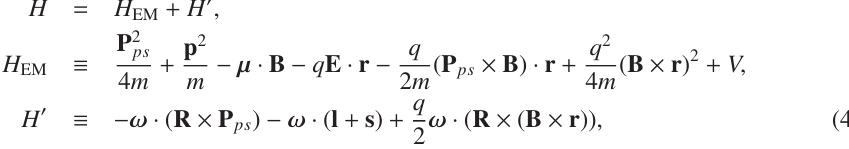
y plane, but the symmetry is broken when the vacuum) is a symmetric function in the x − magnetic field is turned on. When the magnetic field is strong enough, a new potential well forms and the c ¯ c bound state may tunnel from the strong interaction well to the magnetic well, as shown in Fig. 1. This is also known as Lorentz ionization [20]. The vortical field will deepen (shallow) the magnetic well. The vorticity will catalyze the transition from a strongly to an electromagnetically and rotationally interacting bound